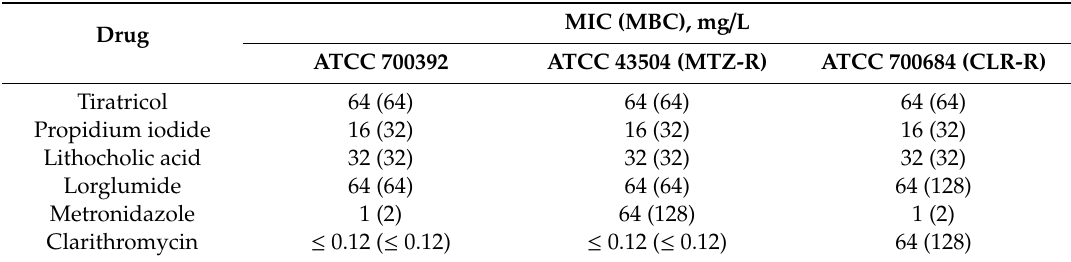
Table 3. Minimal inhibitory and bactericidal concentrations of ArsR inhibitors against di ff erent strains of H. pylori.